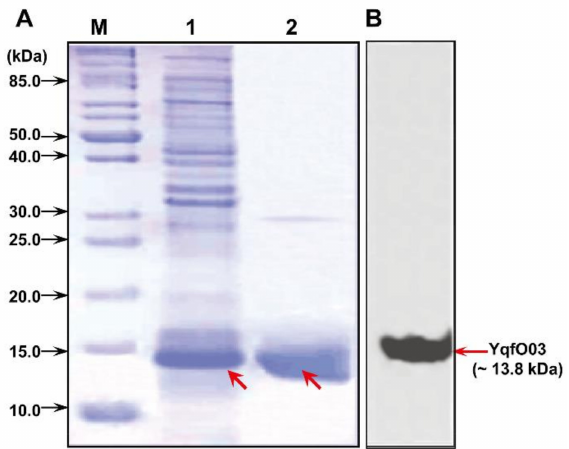
Figure 3. ( A ) SDS-PAGE and ( B ) western blot analyses of the purified YqfO03 protein. In ( A ), lane M: protein molecular weight marker; lane 1: whole-cell lysate of recombinant E. coli MB1171 cells upon IPTG induction; lane 2: purified YqfO03 protein.